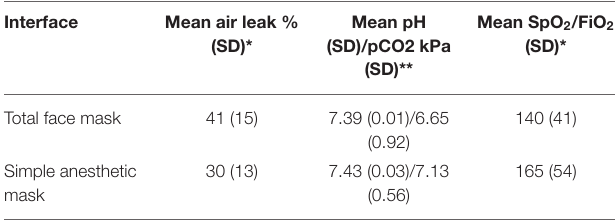
TABLE 1 | Performance of NIV